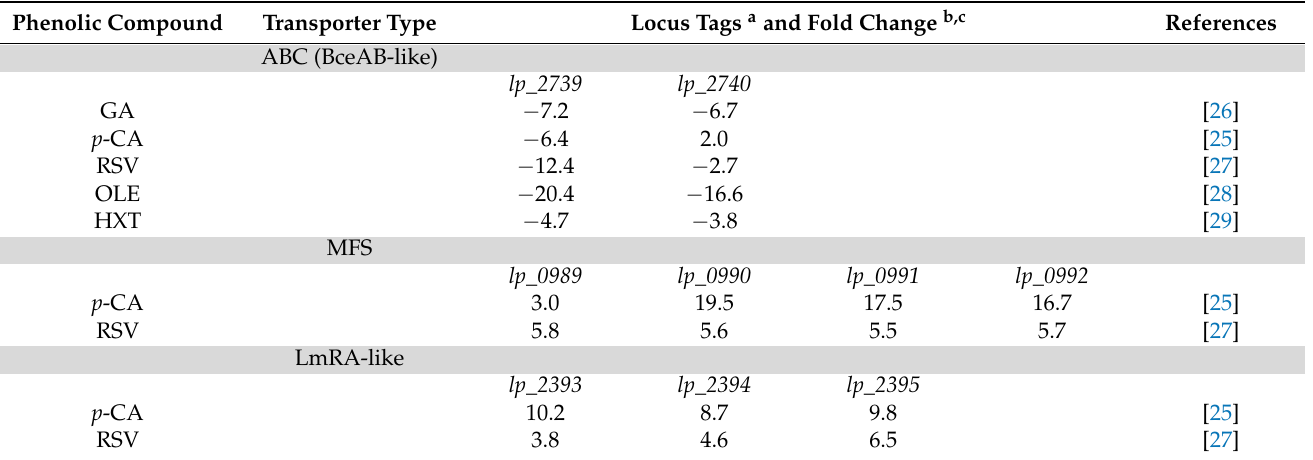
Table 2. Drug efflux and ABC transport systems of Lactiplantibacillus plantarum WCFS1 differentially expressed in presence of plant phenolic